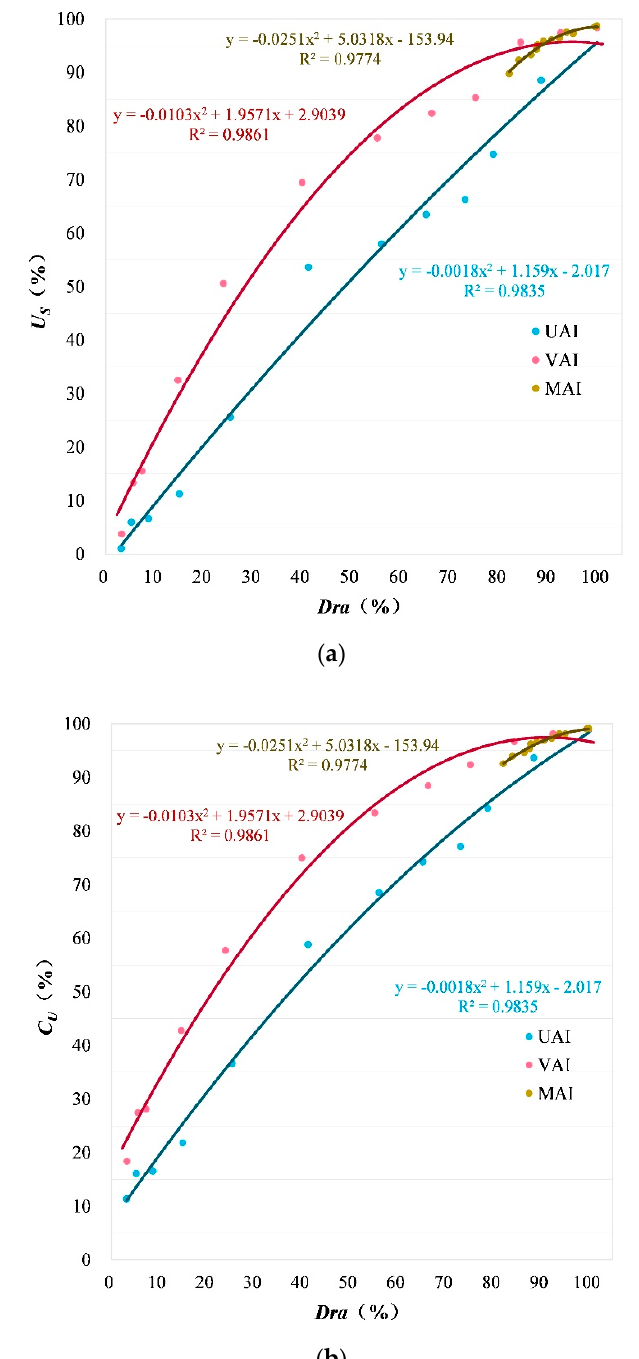
Figure 7. Relationship between uniformity coefficient and average flow ratio. ( a ) The relevance between the statistical uniformity coefficient U s and the mean flow ratio Dra. ( b ) The relevance between Christiansen uniformity coefficient C u and mean flow ratio Dra.